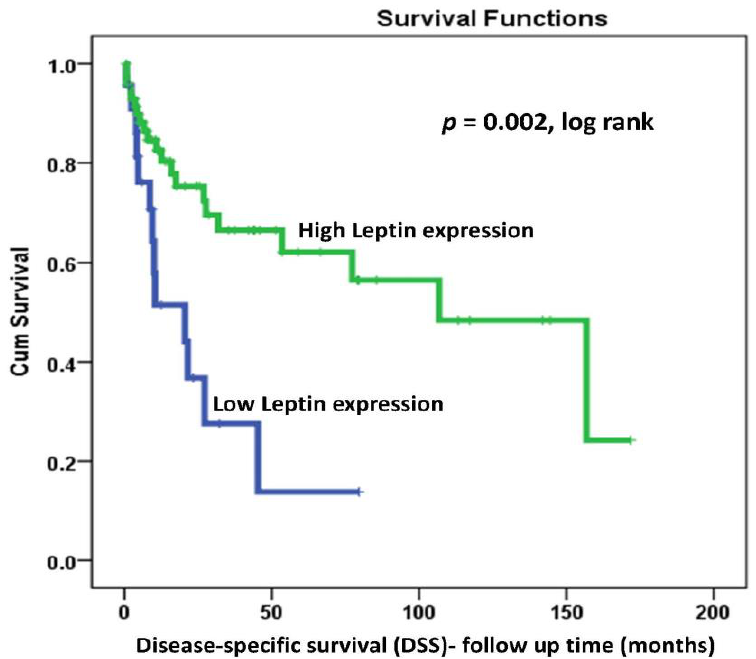
Figure 3. Kaplan – Meier analysis of the association between LEP protein expression pattern and Disease-Specific-Survival (DSS) in OC patients using (low versus high expression as a discriminator ( p = 0.002, log-rank).